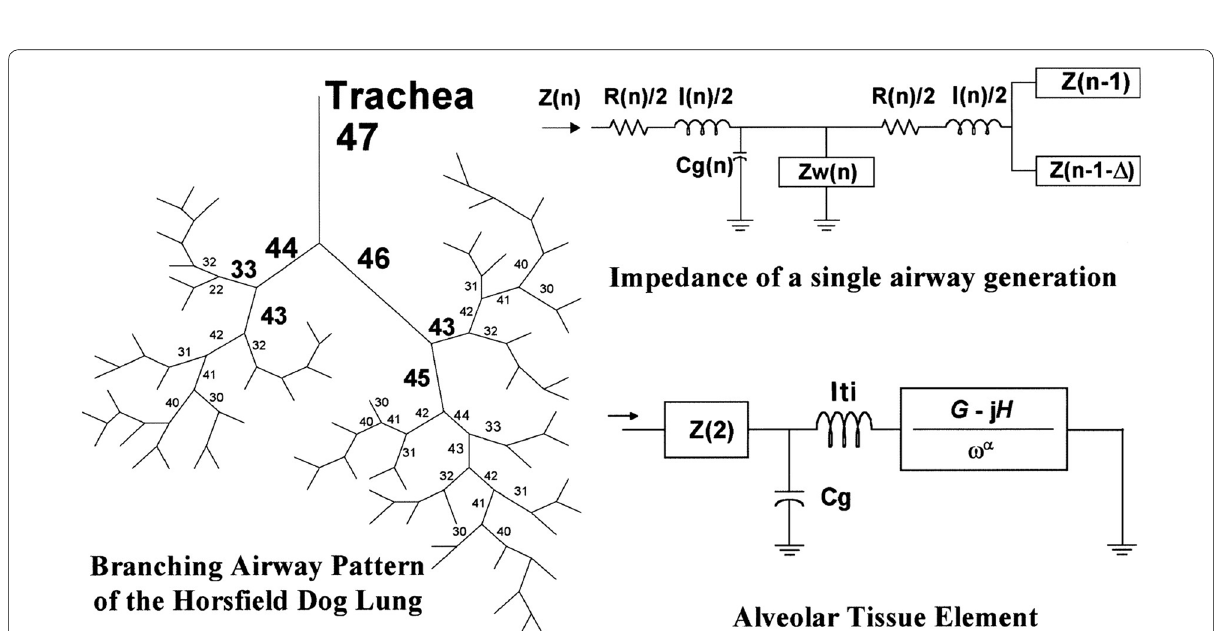
Fig. 1 Schematic of the Horsfield lung model. Individual airways are modeled with a lumped six element model with an alveolar tissue element at the terminal units based on a given order (n) and a recursion index (Δ). The dog lung model depicted here is comprised of 47 airway orders with a defined length and diameter. Each airway consists of a resistive component (R), an inertial component (I), and as well as a term to account for shunting into gas compression in the tube (Cg) and into nonrigid airway walls (Z w ). The viscoelastic alveolar tissue element is modeled with a tissue damping term (G) coupled to elastance (H) and an inertial tissue component (I ti ) with a gas compression corresponding to the volume of the alveolus (Cg) (reproduced with permission from